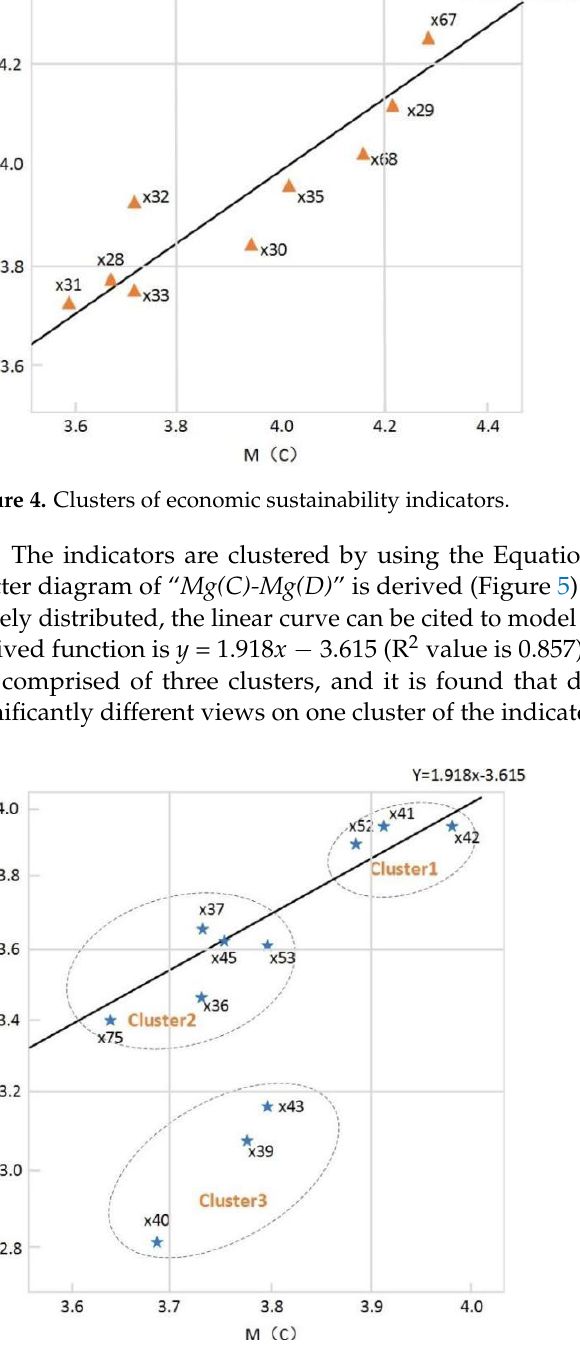
Figure 5. Clusters of greenness indicators